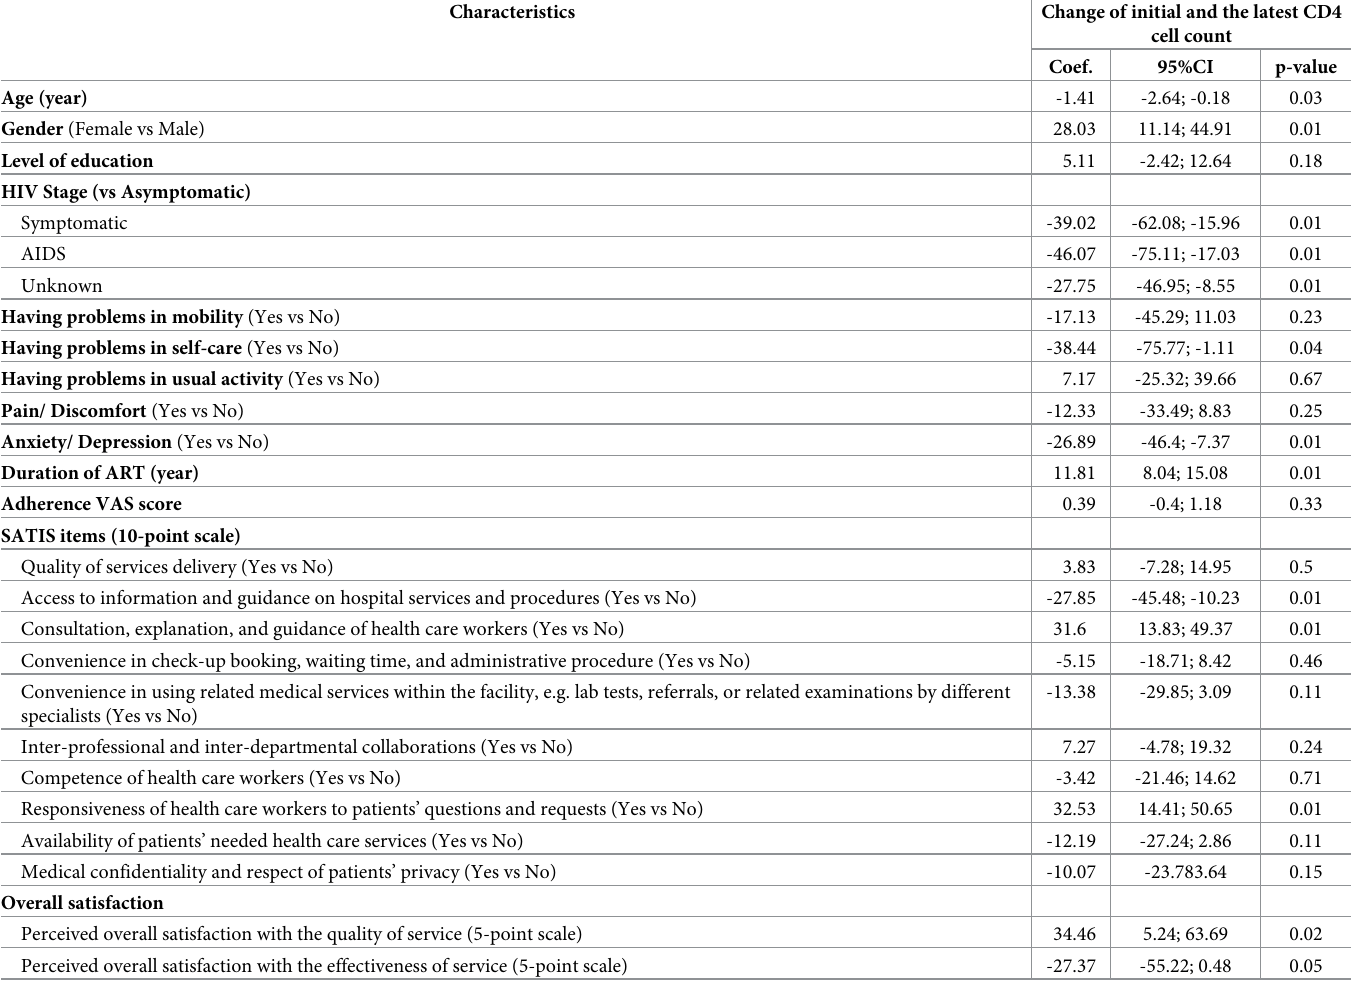
Table 5. Associations between patient satisfaction and change of initial and the latest CD4 cell count.